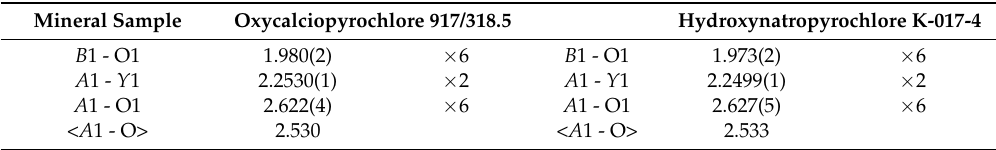
Table 8. Selected bond distances (Å) for oxycalciopyrochlore 917/318.5 and hydroxynatropyrochlore K-017-4 crystal